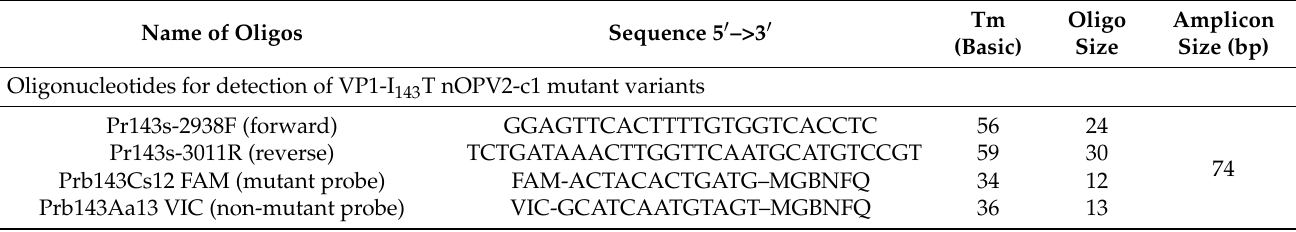
Table 1. Primers and probes used in qmosRT-PCR assay for quantification of the nOPV2-c1 VP1-143T, VP1-171D, and VP1-295K